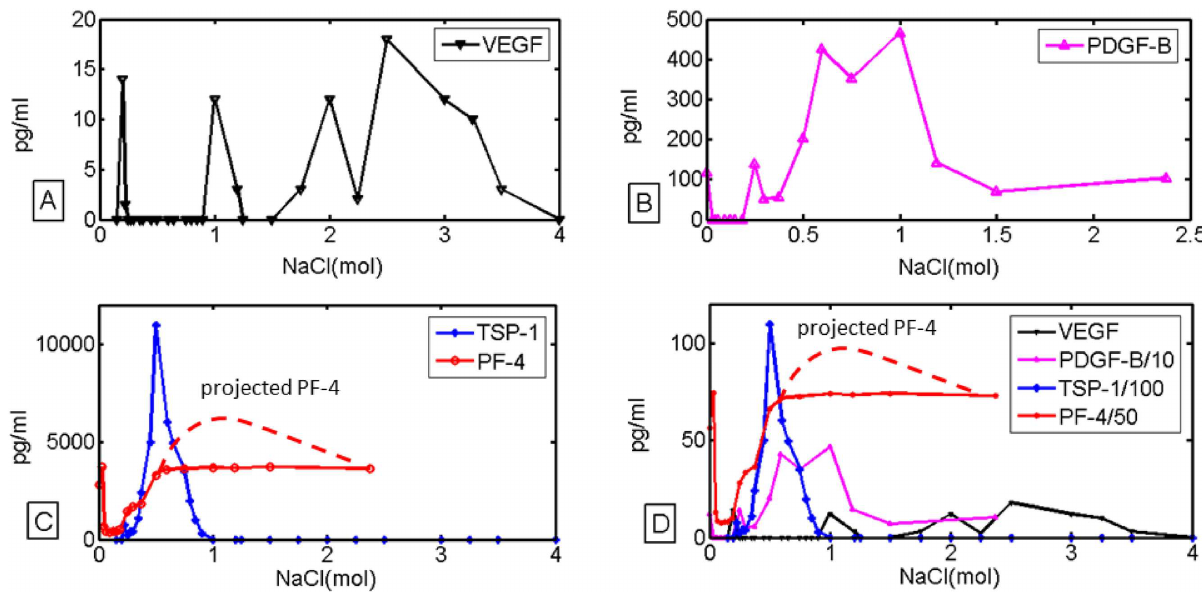
Fig 1. Releaseof angiogenesis regulators from platelets is sequential. The activity of tissue proteases such as heparinase, which is an enzyme that cleavesheparansulfate from the cell membranes, is simulatedby increasedconcentrations of NaCl. As shown in a, b and c, higherconcentrations of NaCl are requiredfor the release of growth factors with higherheparansulfate affinities, going from VEGF (a) to PDGF-B (b) to PF-4 and TSP-1 (c). The observedplateauin PF-4 was due to the detection limit of the PF-4 ELISA. The predictedshape of the curve in the absenceof ELISA detection limit is shown as a dotted red line. Fig 1D shows an overlayof each protein with PDGF-B divided by 10, PF-4 dividedby 50 and TSP-1 dividedby 100. Each experiment was repeated 3 times in technicalduplicate.